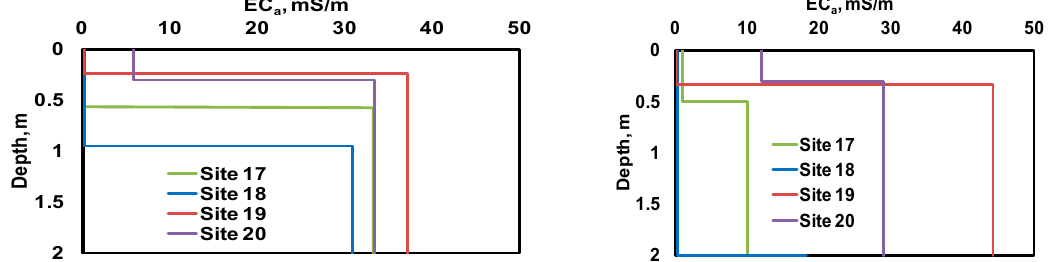
Figure 9. Soil profiles modeled using DUALEM-21S ( left ) and scanner system ( right )